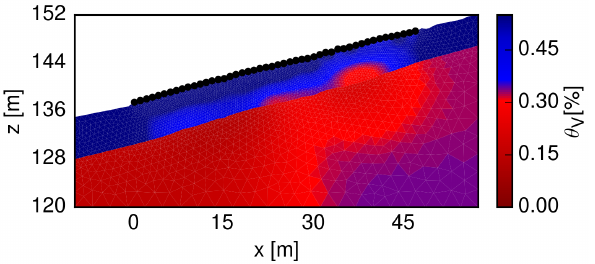
Figure 5. Water content derived from ERT measurements taken at 31 May